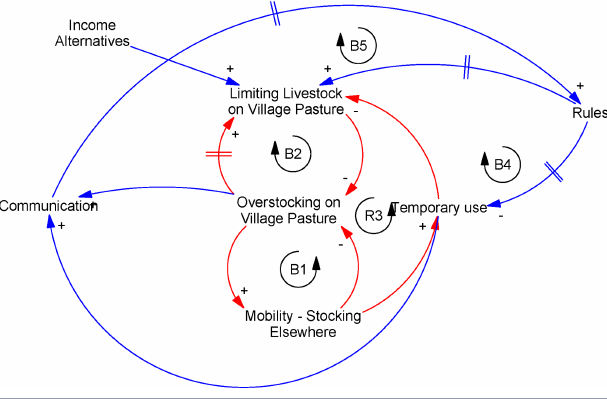
Fig. 6 . The Shifting the Burden archetype applied to livestock mobility as the short-term fix for overstocking problems (red) and its solution by communication and rule design